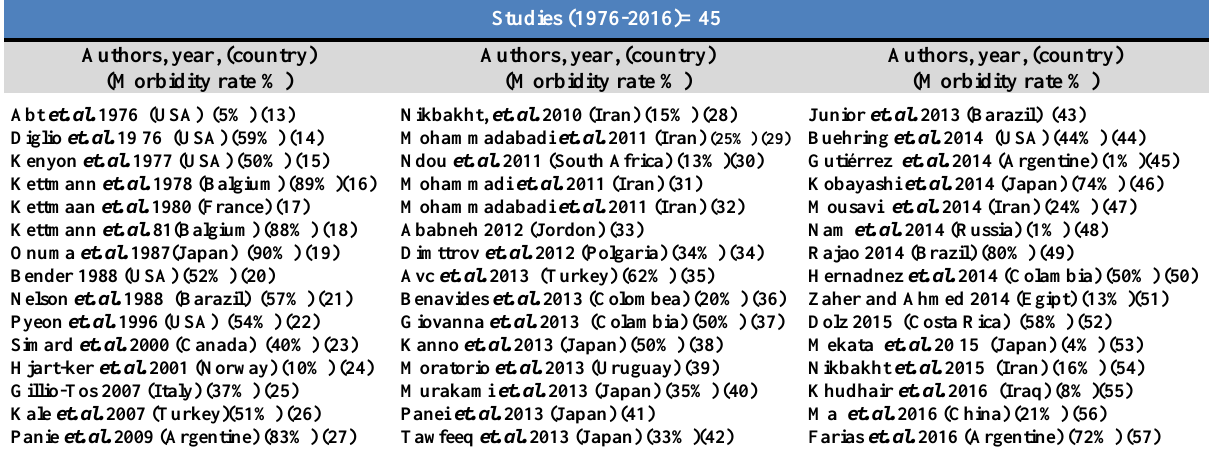
Table, 1: Studies (authors and year of established) ascending arrangement with countries and morbidity rate.